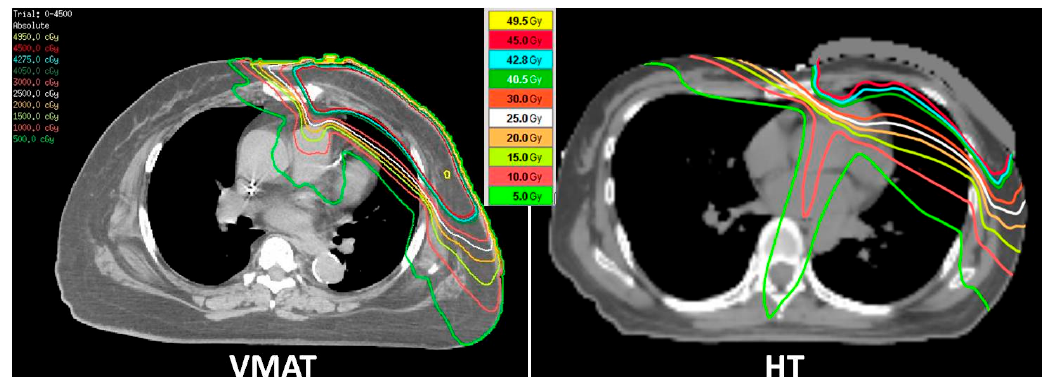
Figure 2. Difference in dose distribution between VMAT and HT. The VMAT technique ( left side ) reduced the normal organ exposure dose, including ipsilateral lung dose V5–V20, heart, contralateral breast and esophagus compared with HT ( right side ). Table 2. Comparison of RT treatment factors and dosimetry parameters between VMAT and HT in all eligible patients. Characteristics